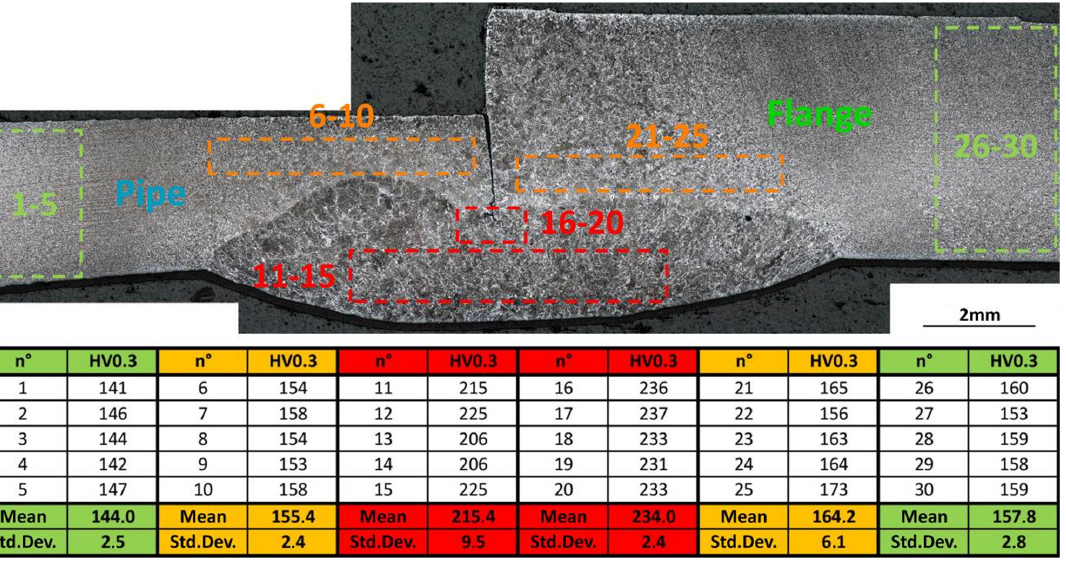
Figure 9. HV0.3 micro-hardness values obtained in the base metal and the heat-affected and